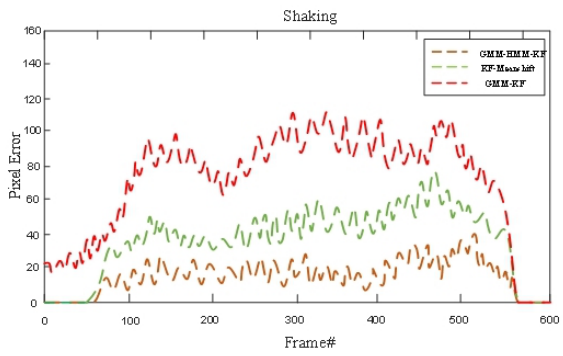
Fig. 18. The average pixel error of the three algorithms in video 2